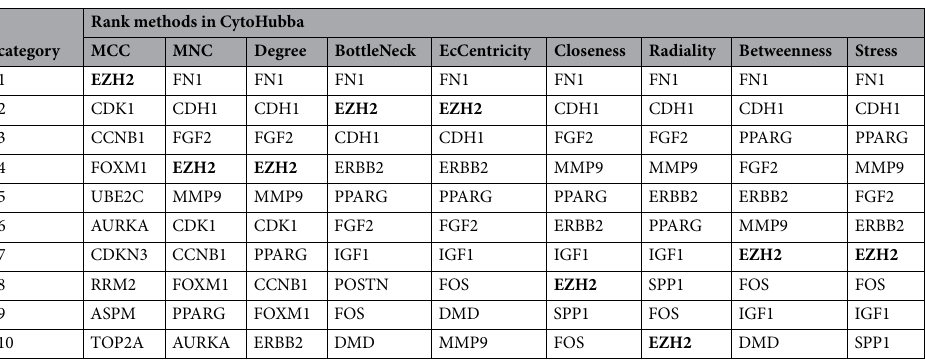
Table 2. Hub genes for highly expressed genes ranked by different CytoHubba